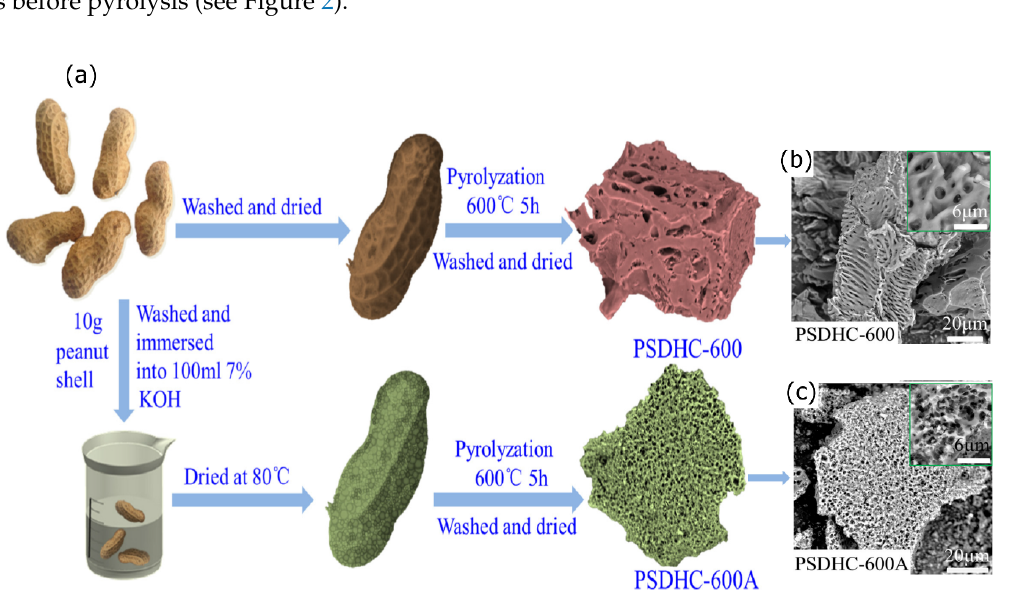
Figure 2. (a) Effect of the chemical treatment on the AC properties, (b,c) SEM images of the ACs. Figure 2. ( a ) E ff ect of the chemical treatment on the AC properties, ( b , c ) SEM images of the ACs. Figure reproduced and adapted from reference [57] with permission from Elsevier. Figure reproduced and adapted from reference [57] with permission from